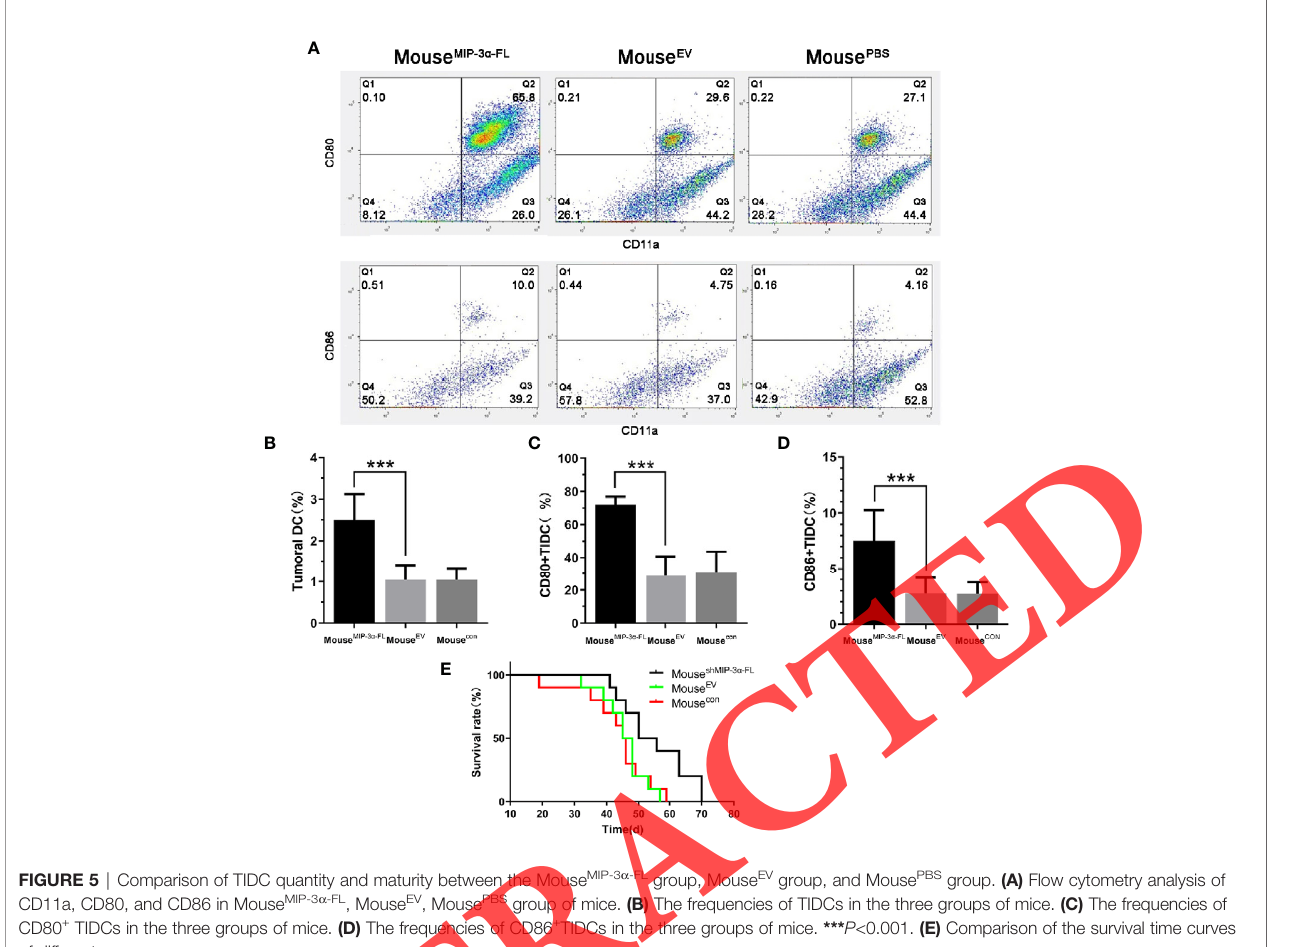
FIGURE 5 | Comparison of TIDC quantity and maturity between the Mouse MIP-3 a -FL group, Mouse EV group, and Mouse PBS group. (A) Flow cytometry analysis of CD11a, CD80, and CD86 in Mouse MIP-3 a -FL , Mouse EV , Mouse PBS group of mice. (B) The frequencies of TIDCs in the three groups of mice. (C) The frequencies of CD80 + TIDCs in the three groups of mice. (D) The frequencies of CD86 + TIDCs in the three groups of mice. *** P <0.001. (E) Comparison of the survival time curves of different mouse